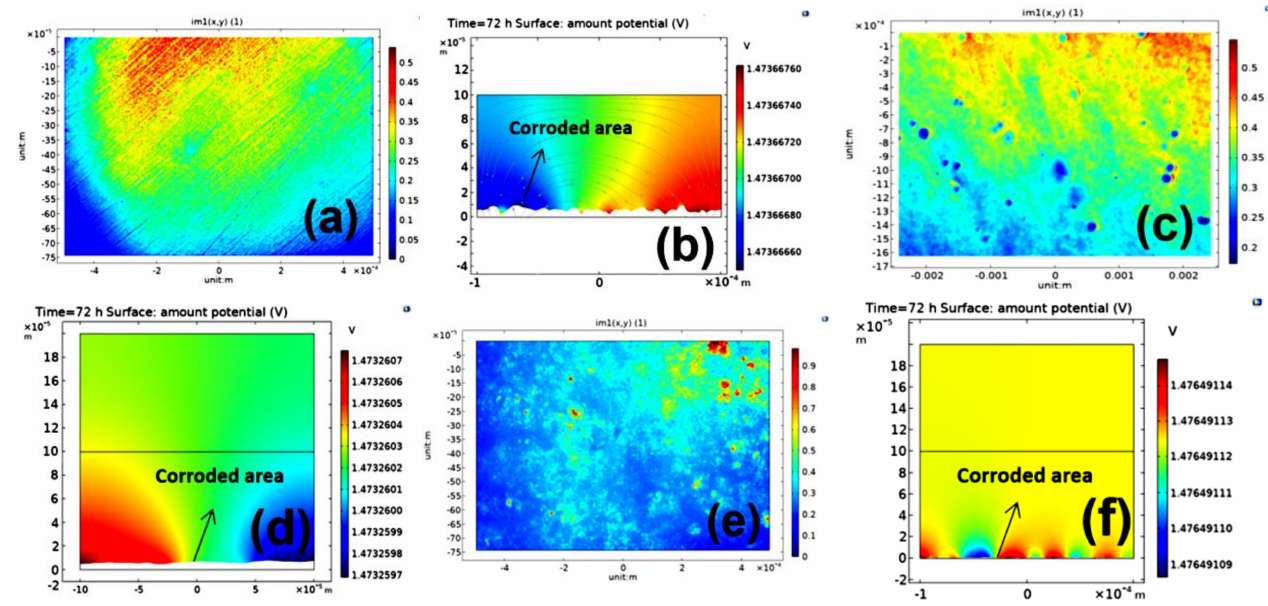
Figure 10. Finite element simulation of corrosion process by COMSOL software: ( a ) Modeling for specimen #1 by Figure 5a; ( b ) for specimen #1 after 72 h corrosion; ( c ) modeling for specimen #2 by Figure 5c; ( d ) for specimen #2 after 72 h corrosion; ( e ) modeling for specimen #3 by Figure 5e; ( f ) for specimen #3 after 72 h